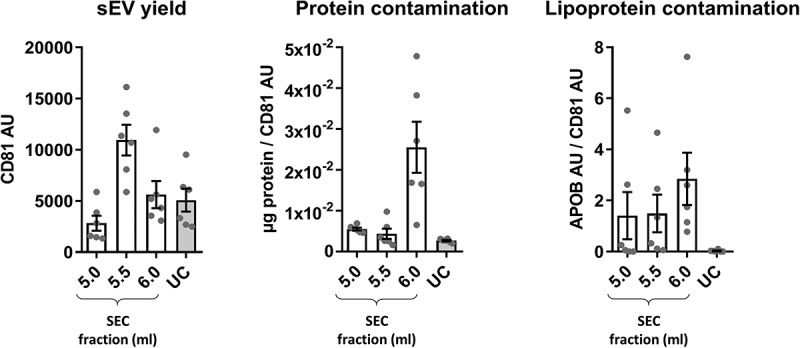
Summary of yield and purity of sEVs isolated by SEC or UC.Summarised key points from Figures 1 to 3. sEV yield (left panel, see Figure 2(a)), protein contamination (middle panel, see Figure 2(g)) and lipoprotein contamination (right panel, see Figures 2(a) and 3(a) shown for the peak sEV fractions (5.0, 5.5 and 6.0 ml) of SEC and UC samples. CD81 signal was used as an estimate of sEV content.